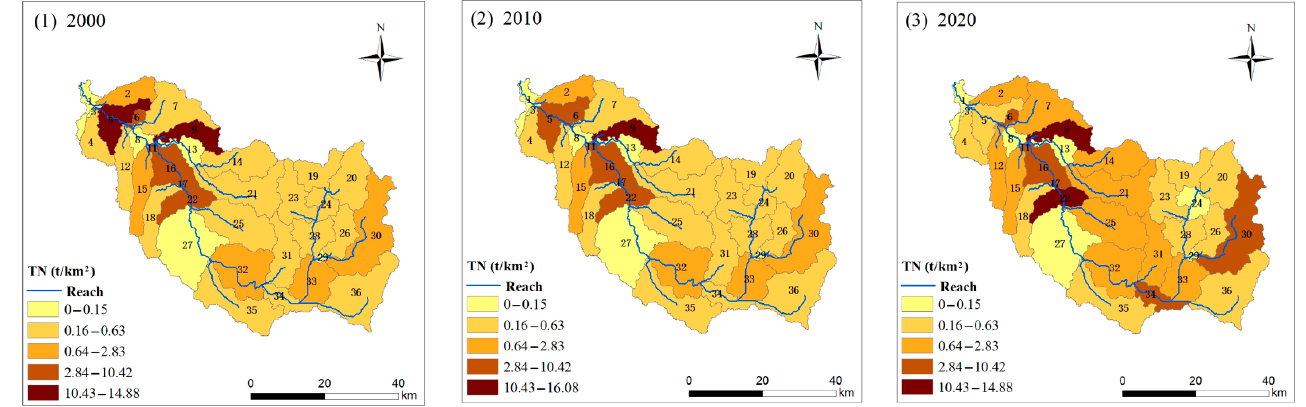
Figure 18. Average annual load per unit of total nitrogen.